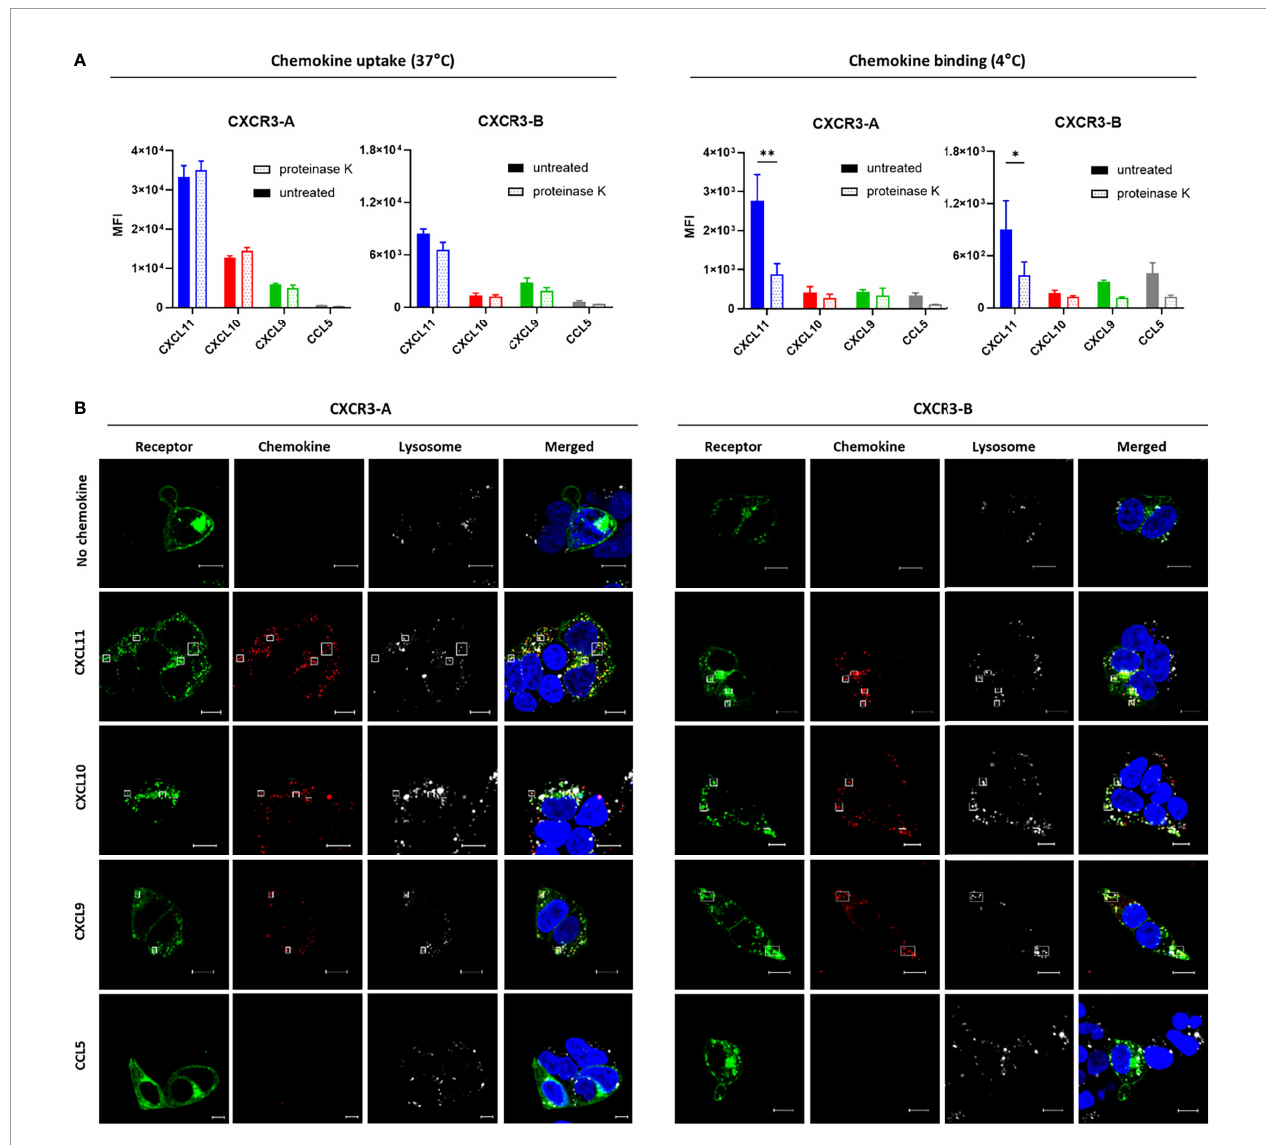
FIGURE 4 | Both CXCR3 isoforms can mediate chemokine uptake. (A) Intracellular accumulation (37°C) and cell surface binding (4°C) of Alexa Fluor 647-labeled CXCL11, CXCL10, CXCL9 and CCL5 (33 nM) monitored by fl ow cytometry in CXCR3-A- and CXCR3-B-expressing cells. After 1-hour incubation cell surface-bound chemokines were removed with proteinase K treatment. Results represent mean ± SEM of three independent experiments. *p < 0.05, **p < 0.01 by two-way ANOVA with Tukey ’ s post hoc analysis. (B) CXCR3-A- and CXCR3-B-driven uptake of Alexa Fluor 647-coupled chemokines visualized by confocal fl uorescent microscopy. Cells transiently expressing CXCR3-A or CXCR3-B fused with mNeonGreen (green) were incubated for 2 hours with chemokines (100 nM) (red). Lysosomes and nucleic DNA were stained using LysoTracker ™ Red DND-99 (white) and Hoechst 33342 (blue), respectively. Pictures are representative of 12 acquired images from three independent experiments. Scale bar: 10 µm. All assays were conducted in HEK293T